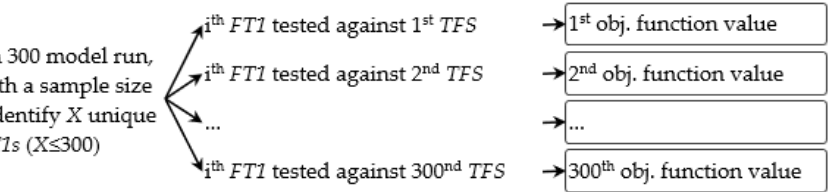
Figure 6. The process to evaluate the quality of each unique FT1 (i.e., the i th FT1) generated by the stochastic program using a specific sample size N.